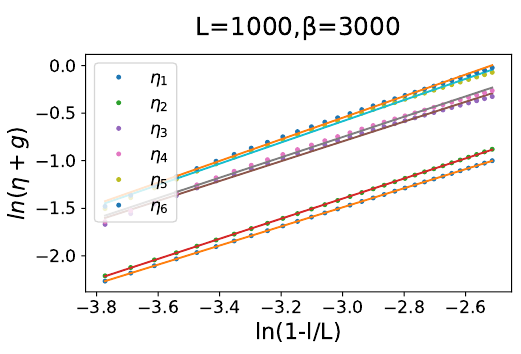
Figure 3 . Numerical check of η 1 to η 6 for large interval limit on a L = 1000 lattice with β/L = 3 . It is straightforward to get ln( η i + g ) = 2∆ ln(1 − l/L ) + c i from (3.18). Indeed the numerical data could be fitted with a straight line with slope 2∆ = 1